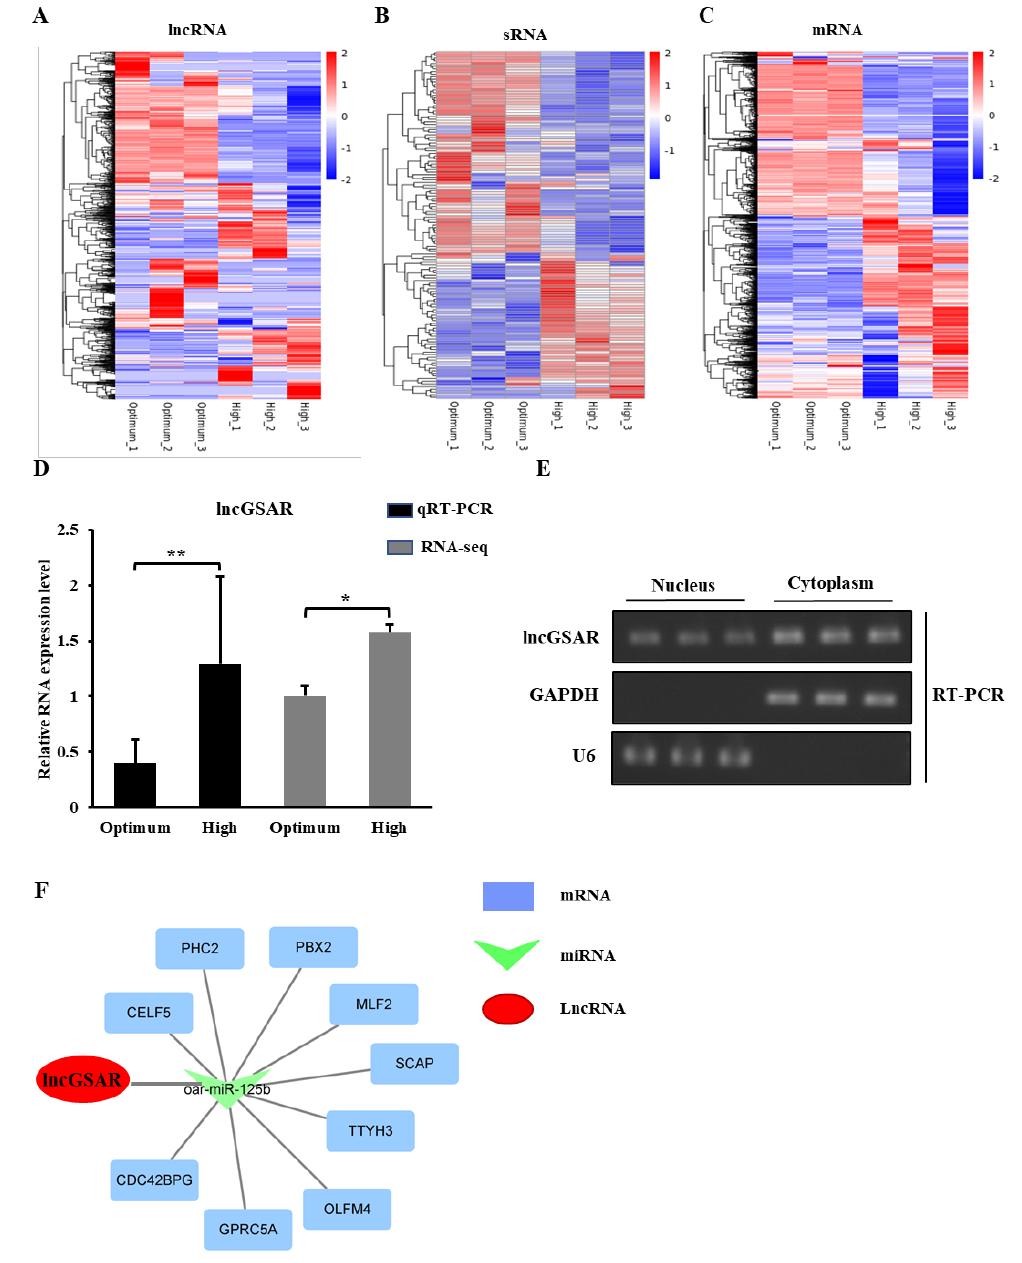
Figure 1. LncRNA-miRNA-mRNA interaction network. ( A – C ) Heatmap of long non-coding RNAs (lncRNAs) ( A ), microRNA (miRNA) ( B ), and mRNAs ( C ) showing hierarchical clustering of changed lncRNAs, miRNA, and mRNAs of granulosa cells (GCs) in different glucose treatment groups; up- and downregulated genes are colored in red and blue, respectively. ( D ) Quantitative real-time PCR (qRT-PCR) validations and RNA sequencing (RNA-seq) of lncGSAR in GCs from in different glucose treatment groups. ( E ) LncGSAR is localized in the cytoplasm and nucleus. GAPDH and U6 serve as cytoplasmic and nuclear localization controls, respectively. ( F ) LncRNA-miRNA-mRNA interaction network consists of one lncRNA (red circle), one miRNA (green arrow), and nine mRNAs (blue squares). Values represent means ± SEM for three individuals. * p < 0.05 and ** p < 0.01. Protein-coding RNAs (mRNAs) and lncRNAs, which share the common miRNA re- sponse elements (MREs), can both compete for binding to miRNAs and regulate each